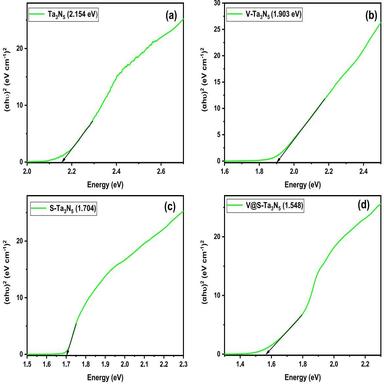
The band gap energies of the (a) pristine Ta3N5, (b) V-doped Ta3N5, (c) S-doped Ta3N5, and (d) V@S co-doped Ta3N5 calculated by Tauc plot.